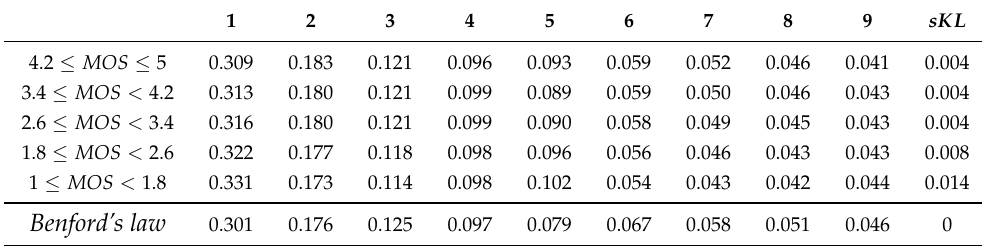
Table 1. Mean FDD of X directional gradient magnitudes in KoNViD-1k [22] with respect to different MOS intervals. In KoNViD-1k [22], the lowest possible video quality is represented by MOS = 1.0, while MOS = 5.0 stands for the highest possible video quality. In the last column, the symmetric Kullback–Leibler ( sKL ) divergences between the actual FDD and the Benford law distribution are given.